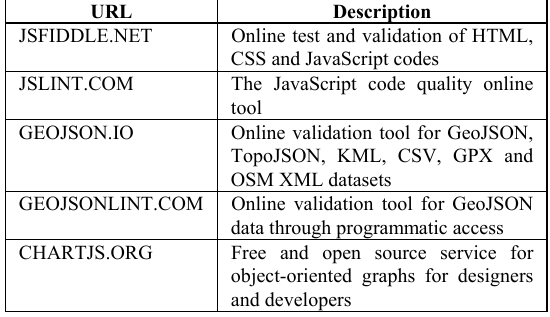
Table 3. List of selected services for the education